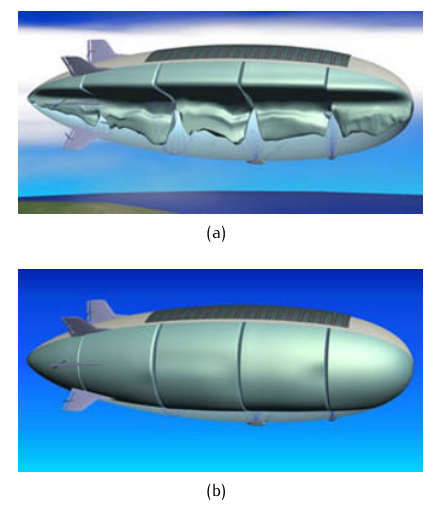
Figure 1. External auxiliary balloons for HAA Berkut airship: at sea level (a) and at pressure altitude (b) [22]. Reproduced under permission of